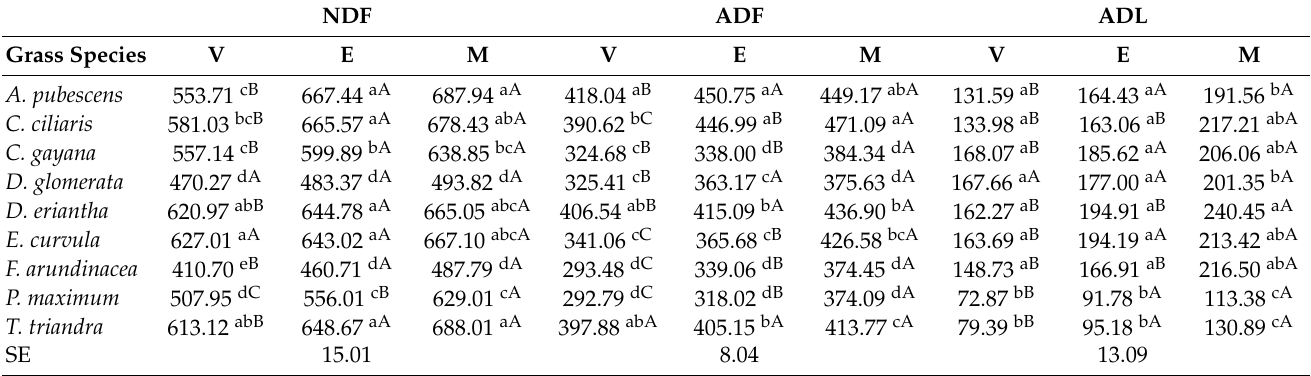
Table 4. Effect of species and growth stage on fibre fraction and lignin (DM in g/kg) in nine selected grass species grown under controlled conditions. NDF ADF ADL Grass